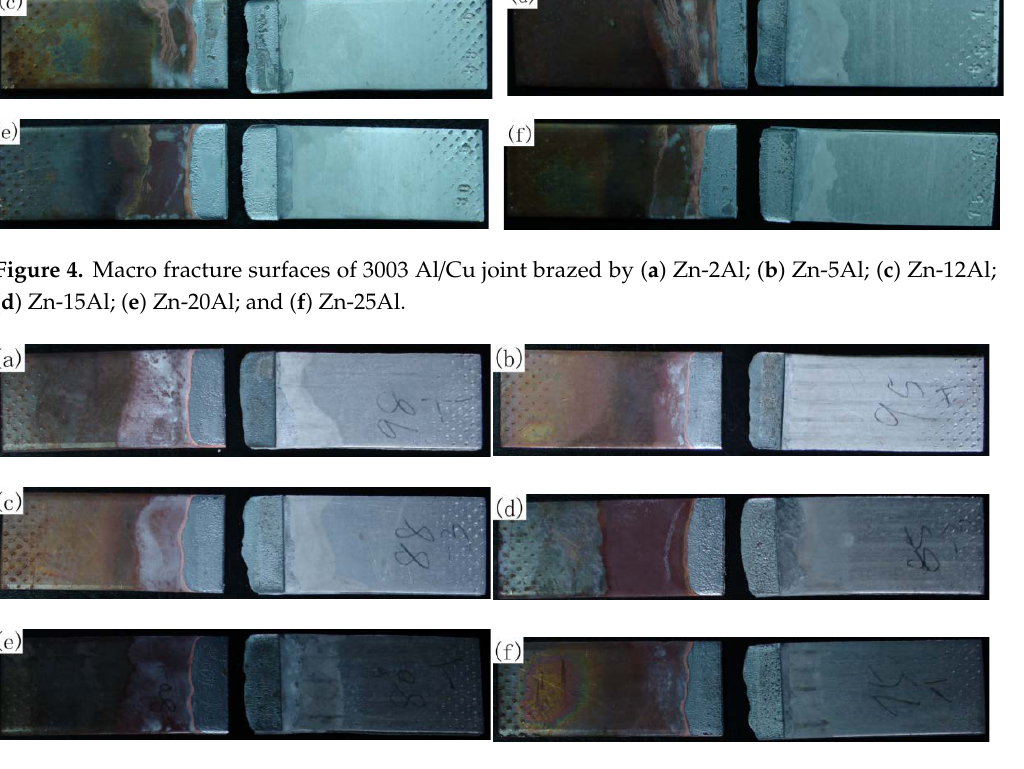
Figure 4. Macro fracture surfaces of 3003 Al/Cu joint brazed by ( a ) Zn-2Al; ( b ) Zn-5Al; ( c ) Zn-12Al; ( d ) Zn-15Al; ( e ) Zn-20Al; and ( f ) Zn-25Al.